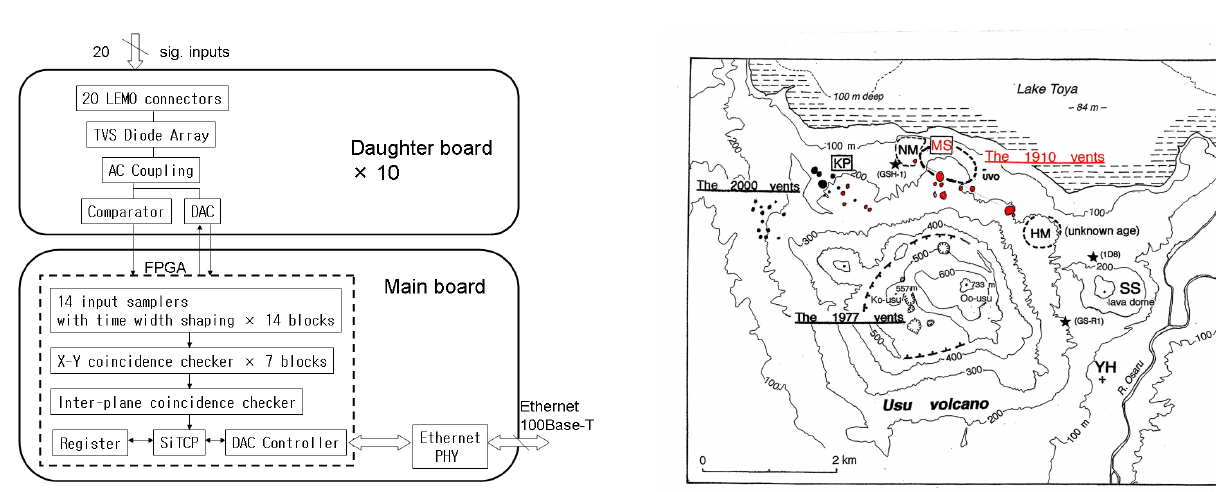
Fig. 3. Block diagram of MURG12. Fig. 4. Topographic sketch map of the Usu volcano. KP: Kom- pira craterlet group, MS: Meiji-Shinzan craterlet group, NM: Nishi- Maruyama mound, HM: Higashi-Maruyama mound, SS: Showa- Shinzan lava dome, YH: Yanagi-Hara mound. Muon detection sys- tem is placed at UVO: Usu Volcano Observatory in this